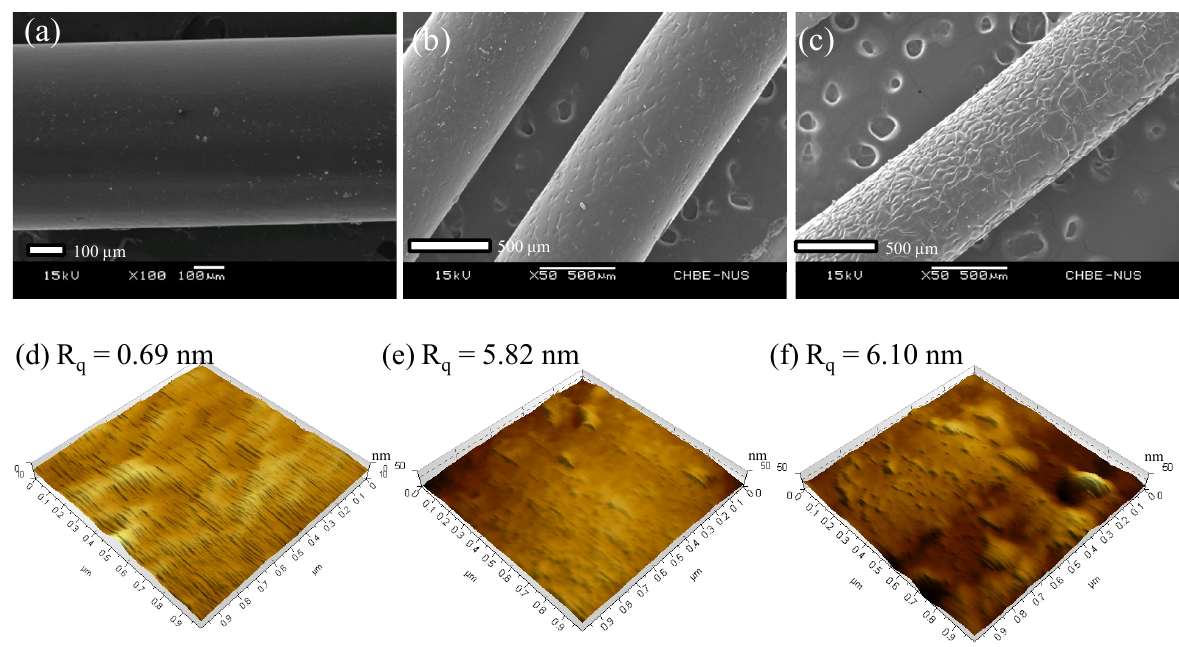
Figure 3. The SEM images of the outer surfaces of ( a ) the annealed PBI/PES membrane; ( b ) the as-spun PBI-POSS/PAN membrane and ( c ) the annealed PBI-POSS/PAN membrane. Only the annealed PBI-POSS/PAN membrane exhibits a micrometer-scale ridge and valley structure. The AFM images of ( d ) the CA membrane; ( e ) the PBI/PES membrane and ( f ) the annealed PBI-POSS/PAN membrane. The z -axis (thickness direction) scale is 10 nm for the CA membrane and 50 nm for the PBI membranes, and the scales for x - and y -axes are 1 μ m for